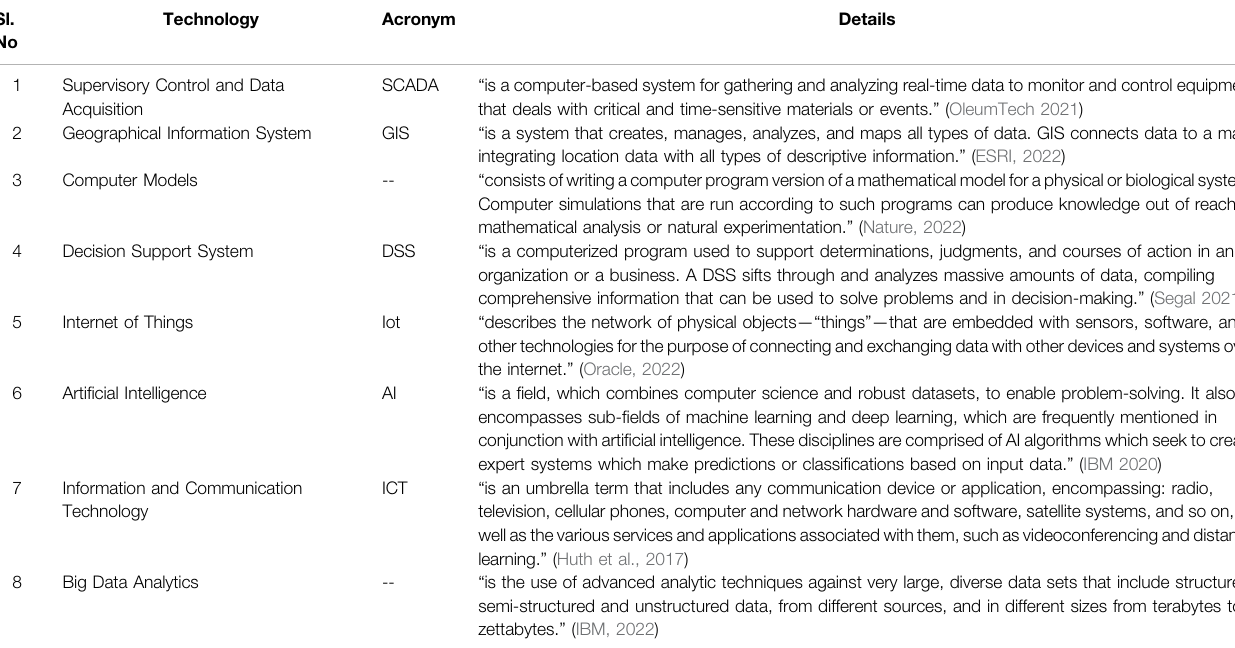
TABLE 1 | List of the various digital technologies that are used in urban water management along with their appropriate de fi nitions. Sl.